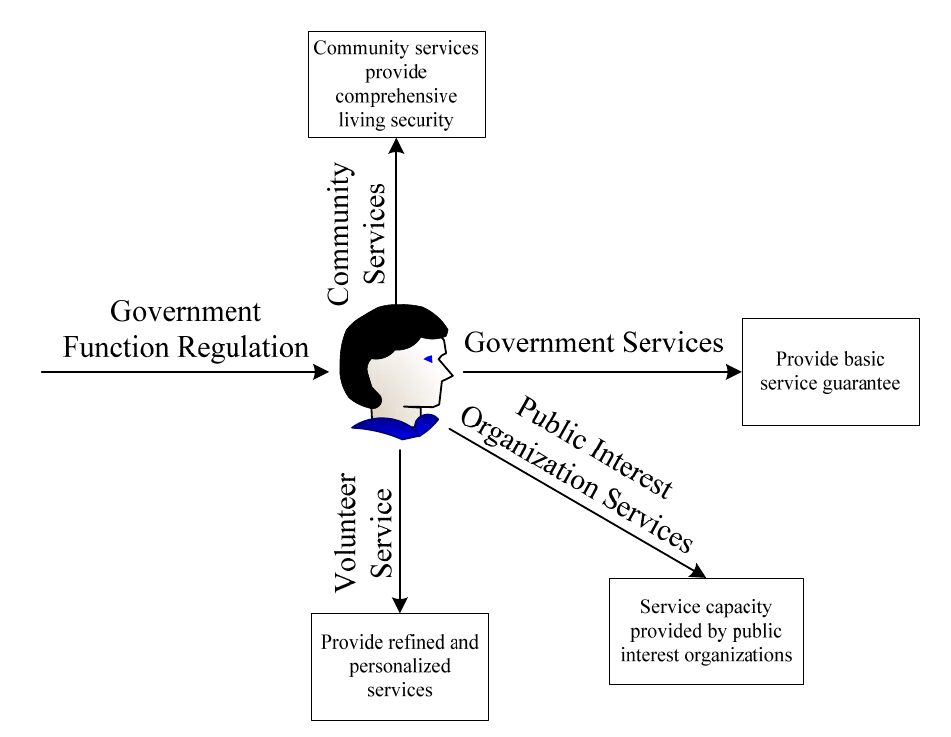
Figure 1. Platform service model diagram.